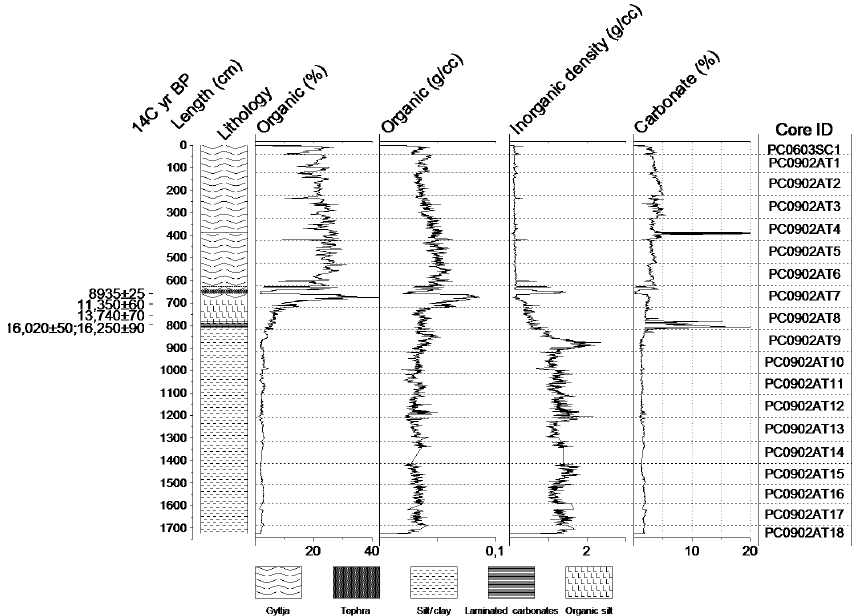
Figure 2. Stratigraphic column, radiocarbon dates and loss-on-ignition data from the Lago Edita record. The labels on the right indicate the identity and stratigraphic span (dashed horizontal lines) of each core